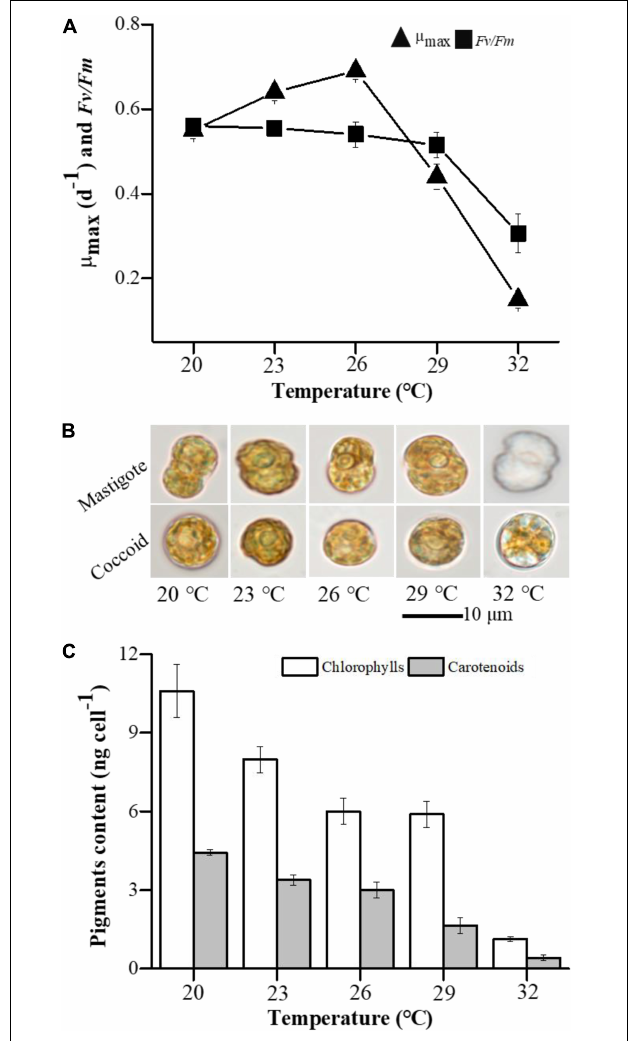
FIGURE 1 | Effect of temperature variations on the growth, photosynthesis and cell morphology of E. voratum SCS01. (A) Variations in the maximal growth rate ( µ max) and the photochemical efficiency of PSII ( Fv/Fm ) in E. voratum SCS01. (B) Representative micrographs (bright field) of mastigote and coccoid cells of E. voratum SCS01 (day 6). (C) Variations in pigment content in E. voratum SCS01 (day